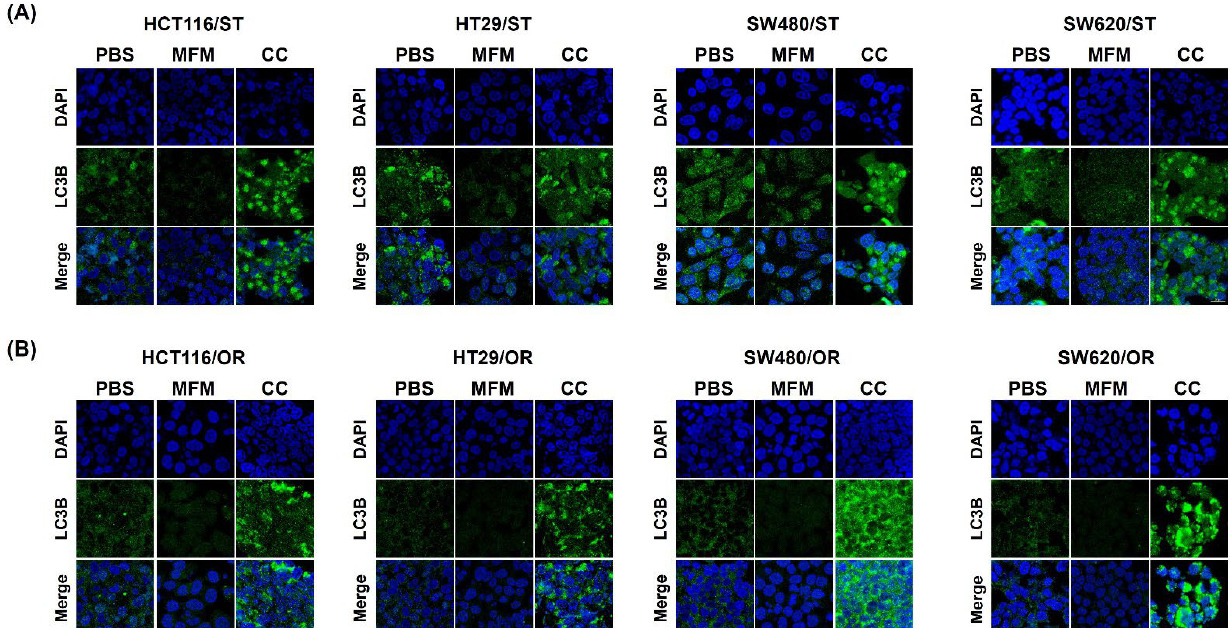
Figure 8. Effects of AMPK on the induction of autophagy in HCT116, HT29, SW480 and SW620 colorectal cancer (CRC) cells by treating metformin as an AMPK activator or compound C as an AMPK inhibitor. ( A ) Parental (PT) CRC cells were pretreated with or without 20 mM metformin and 10 µM compound C followed by 2.5 µM oxaliplatin for 24 h. ( B ) Oxaliplatin-resistant (OR) CRC cells were pretreated with or without 20 mM metformin and 10 µM compound C followed by 2.5 µM oxaliplatin for 24 h. LC3B was visualized by immunofluorescence using confocal microscopy. LC3B protein was labeled green (Alexa 488) and the nucleus was stained with DAPI. The size of scale bar was 20 µm. This experiment was performed in three independent replicates. PBS, phosphate-buffered saline; AMPK, AMP-activated protein kinase; MFM, metformin; CC, compound C. Analysis of the protein expression also confirmed the above results that phospho-AMPK was increased and LC3B-II was decreased by metformin treatment in ST CRC cells, along with an increase in phospho-Akt (Figure 9A). Metformin also increased the protein expression of GLUT1, PFKFB3 and PFK1 in ST CRC cells (Figure 9A). On the contrary, phospho-AMPK was decreased and LC3B-II was increased by compound C treatment in ST CRC cells, along with a slight decrease in phospho-Akt (Figure 9B). Compound C also decreased the protein expression of GLUT1 and PFK1 in ST CRC cells and PFKFB3 in SW480/ST and SW620/ST cells (Figure 9B). Co-treatment with metformin increased phospho-AMPK in HCT116/OR and HT29/OR and phospho-Akt in HCT116/OR and SW480/OR cells and the other proteins were comparable or slightly decreased in OR CRC cells (Figure 9C). On the contrary, phospho-AMPK was decreased by compound C treatment, and the expression of LC3B-II was increased by a decrease in phospho-Akt (Figure 9D). Furthermore, the protein expression levels of GLUT1, PFKFB3 and PFK1 were decreased by treatment with compound C in OR CRC cells (Figure 9D). Therefore, inactivation of AMPK appeared to improve oxaliplatin sensitivity in both ST and OR CRC cells through induction of autophagy.